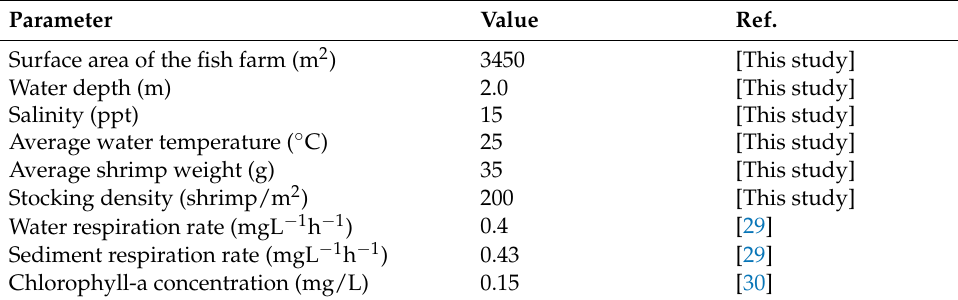
Figure 1. Geographical location of the studied fish farm in Qigu, Tainan, (Google Earth Pro 7.3.3.7786 (2021)). Table 1. Biophysical characteristics of the shrimp